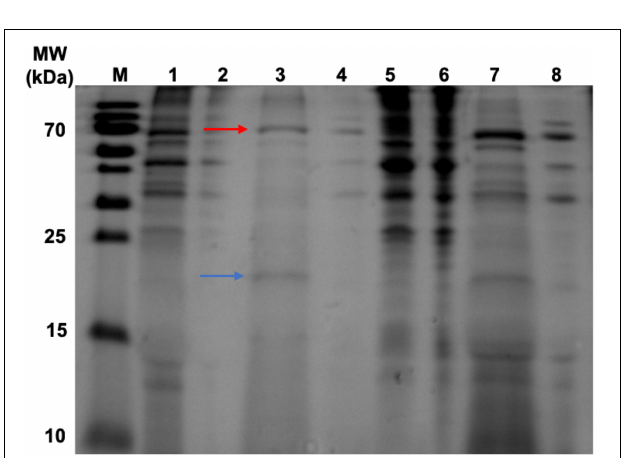
particles relative to the untreated samples. In order to keep in